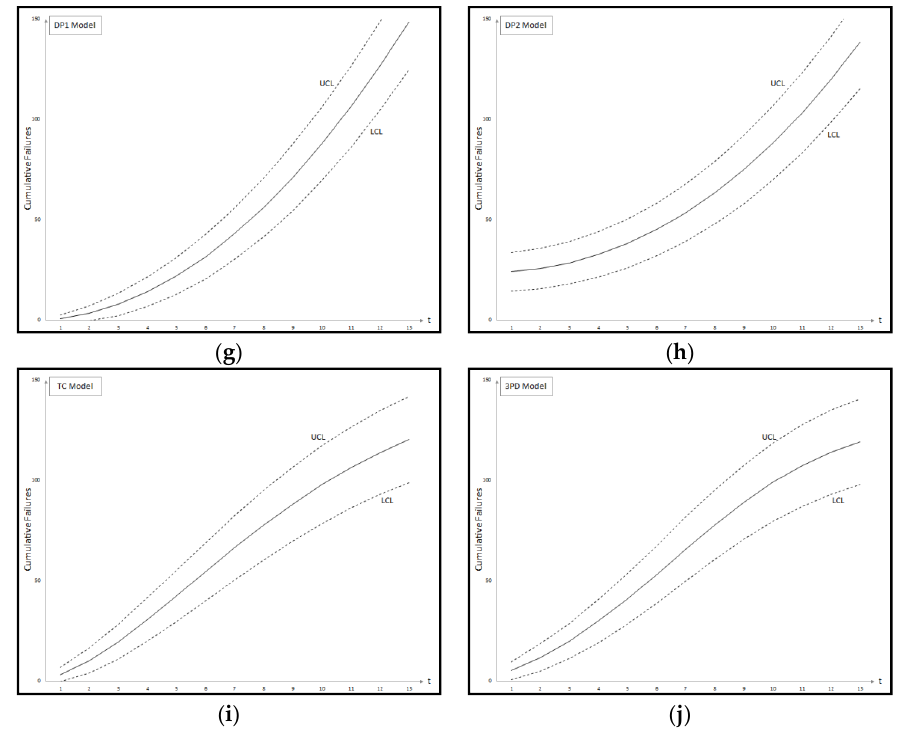
Figure A1. Confidence intervals of all 11 models Dataset #1: ( a ) GO Model; ( b ) Delayed S ‐ shaped SRGM; ( c ) Inflection S ‐ shaped SRGM; ( d ) Yamada Imperfect Debugging Model; ( e ) PNZ Model; ( f ) Pham ‐ Zhang Model; ( g ) Dependent ‐ Parameter Model1; ( h ) Dependent ‐ Parameter Model2; ( i ) Testing Coverage Model; ( j ) Three ‐ parameter Model.